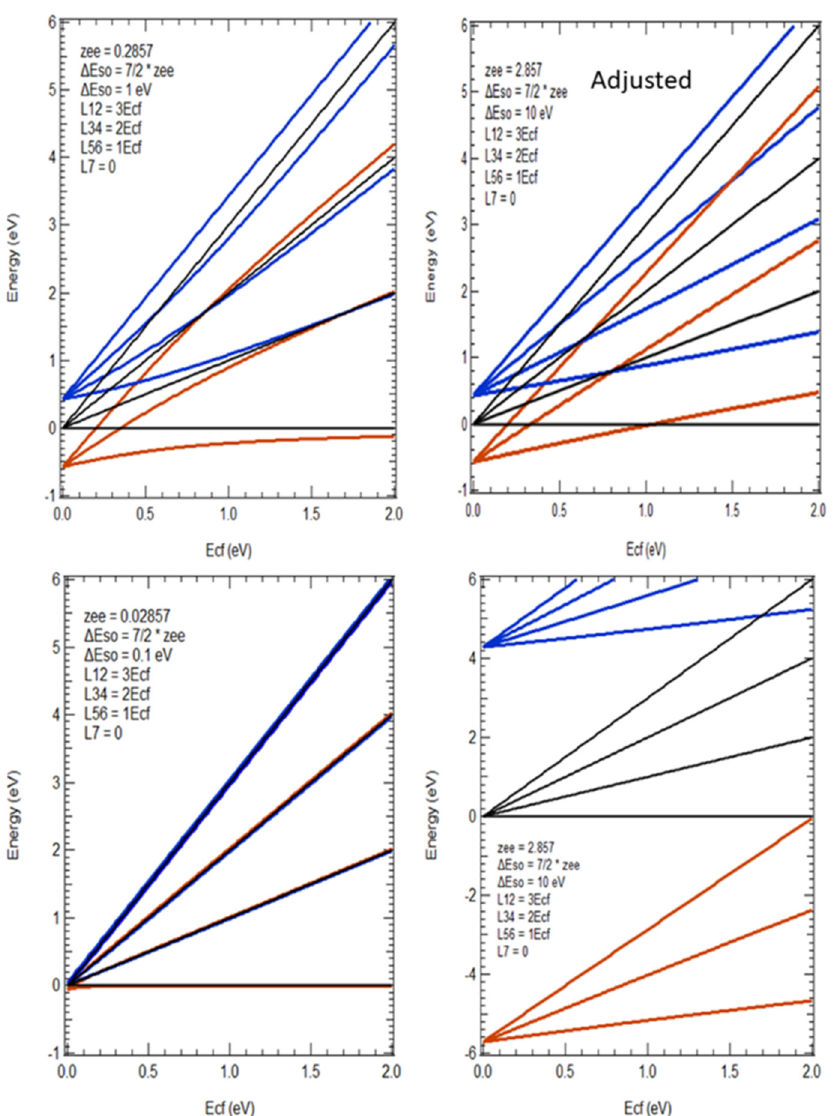
Figure 9. Plots of the Eigenstate energies for various values of Δ E so and E cf are shown here. The states originating at E cf = 0 from the 5f 7/2 (5f 5/2 ) manifold are shown in blue (red). Each line is doubly degenerate. In black, the lines (Lij) corresponding to |m|E cf are also shown. At E cf > 0, there is mixing of the pure 5f 7/2 and pure 5f 5/2 states. See text for details.